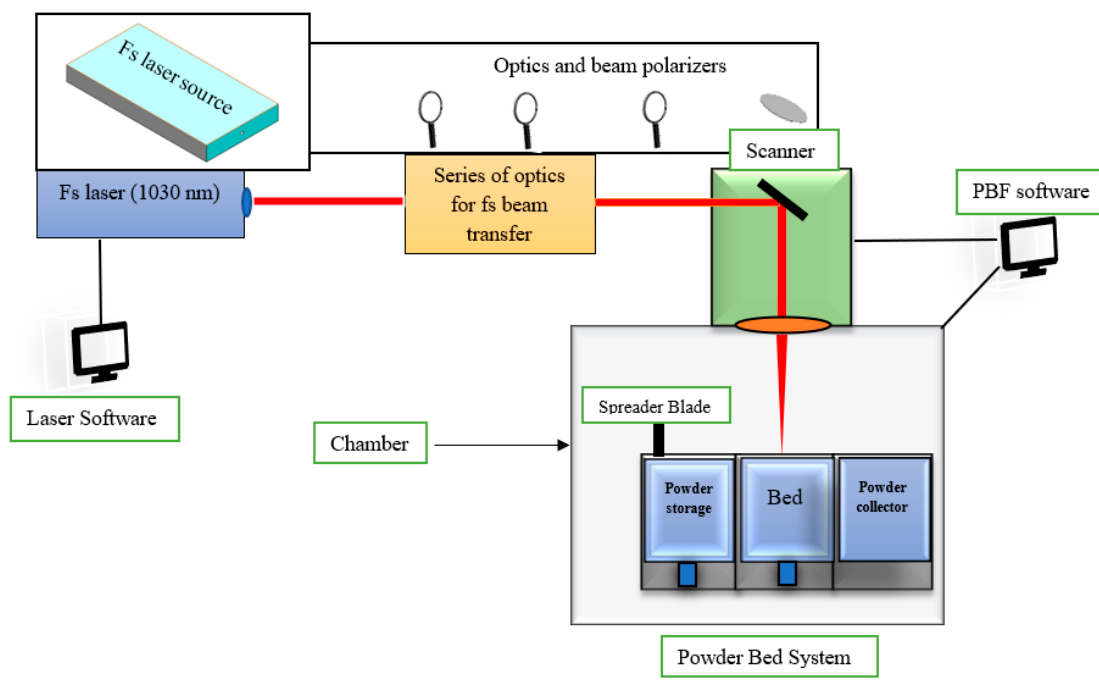
Figure 6. Schematic of the fs-laser-based selective laser sintering–powder bed fusion process.